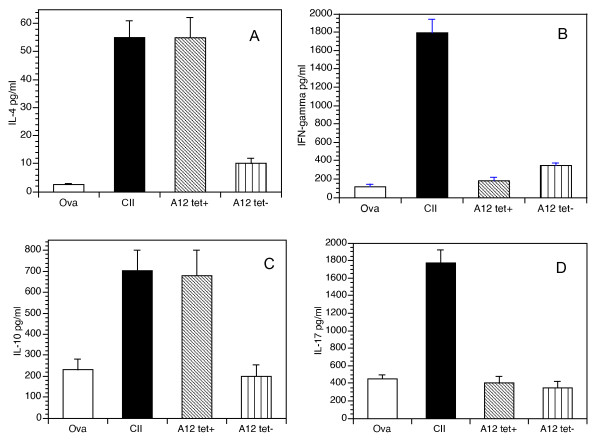
Cytokine responses to A12-tetramer+ cells. DR1 mice were immunized with Ova (open bars), CII (solid bars), or A12 (hashed and striped bars), and the draining inguinal lymph node cells were selected to obtain the CD4+ populations. The A12-immunized lymph node cells were further fractionated into tetramer+ (left hashed bars) and tetramer- (striped bars) populations. The cells were cultured (5 × 105 CD4+ T cells/ml) with wild-type APC (DR1-positive splenocytes; 1:2 ratio) prepulsed in vitro with the immunodominant collagen peptide. Supernatants were collected and tested for the presence of each cytokine by using a multiplexed ELISA. The supernatants were collected from Ova-specific CD4+ T cells (open bars), CII-specific T cells (solid bars), DR1-A12 tetramer+ T cells (left hashed bars), or tetramer- T cells (striped bars). Results shown represent the mean ± SD of three separate experiments and are expressed in picograms per milliliter of culture supernatants. The Th1/Th2 ratio was 13:1 in T cells responding to CII, whereas the Th1/Th2 ration was 0.5:1 in the DR1-A12 tetramer+ T cells.